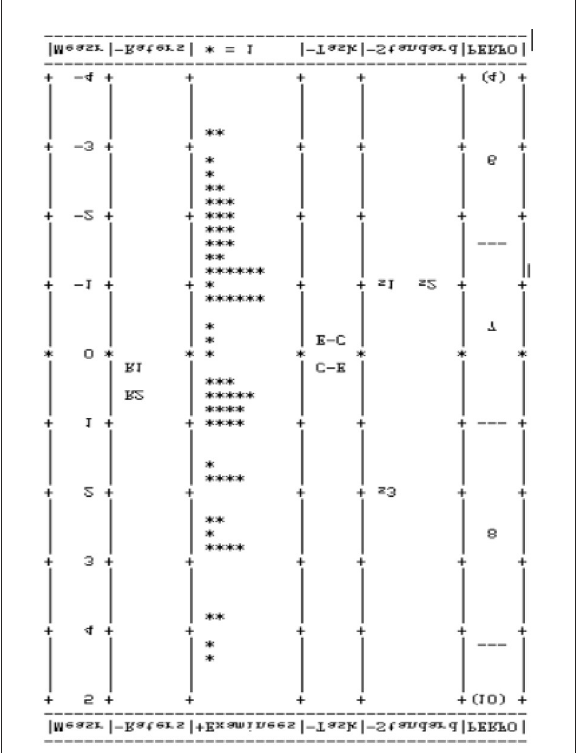
FIGURE1 General distribution of testing results (Measure, logit scale; Raters, relative strictness of raters; * , two-direction interpretation competence of the examinees; Task, diculty of the task; Standard, sub-scales of the rating scale; PERFO, grades of each range on the rating